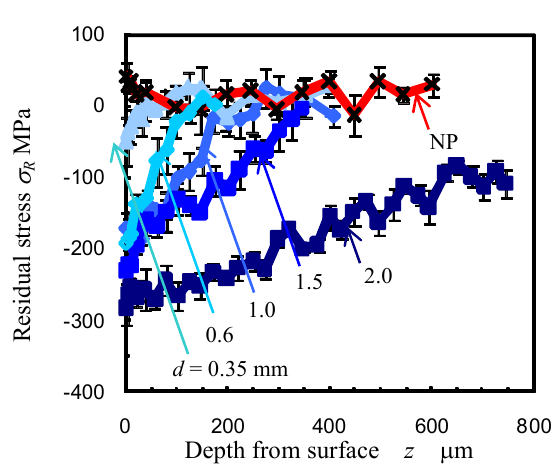
Fig. 9 Variation of residual stress with depth ( p = 30 MPa, p 1